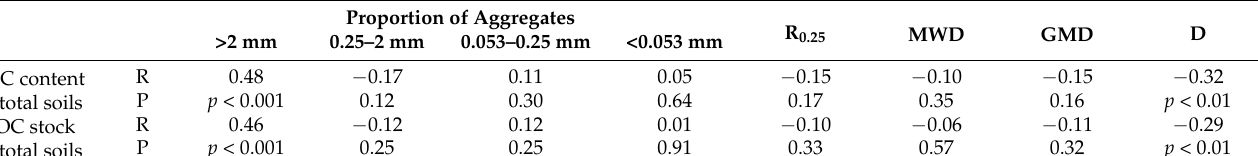
Figure 6. The effects of shelterbelt on aggregate − associated SOC stocks in 0 – 20 cm, 20 – 40 cm, 40 – 60 cm, 60 – 80 cm, and 80 – 100 cm. Broken lines are percent changes of aggregate-associated SOC stocks, * indicates the significant differences at p < 0.05 between the changes in shelterbelt − induced and farmlands in same soil layer. Error bars are the standard errors. Table 2. Relationships between total SOC content (stock) and the distribution and stability parameter of soil aggregates.